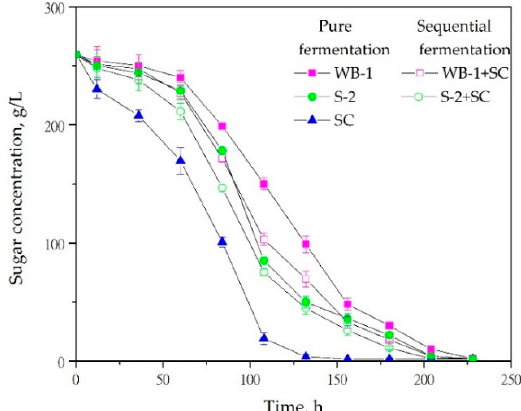
Figure 1. Kinetics of pure and sequential fermentations inoculated with two non- Saccharomyces isolates ( C. famata WB-1 and H. uvarum S-2) and S. cerevisiae QA23 (SC). Data were the mean ± SD of two biological replicates of fermentation.